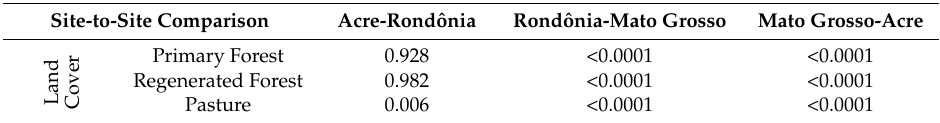
Table 5. Summary of statistical significance ( p -value) of mean dry season ET comparison between the three study sites and different land covers.